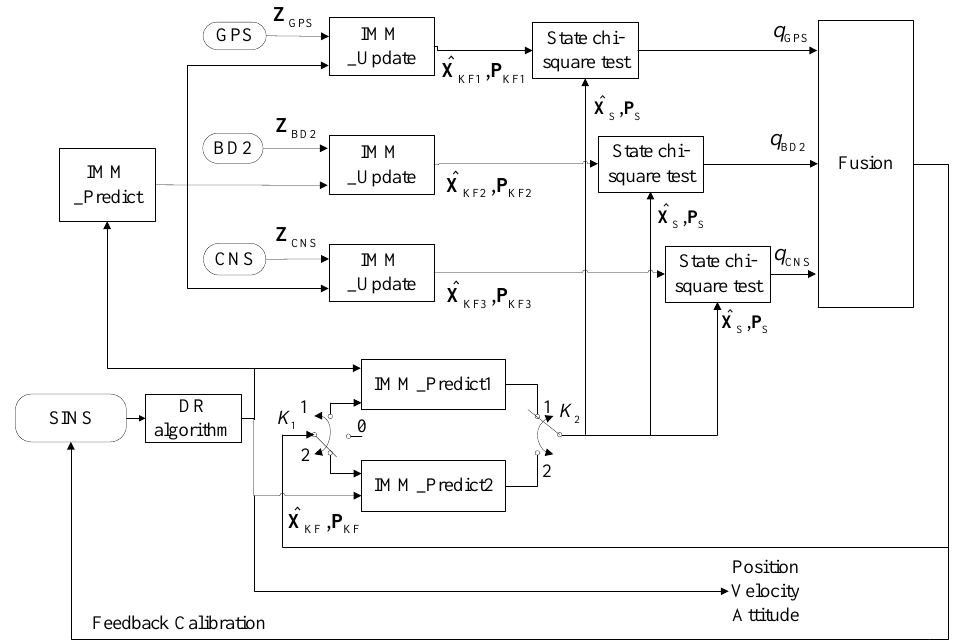
Figure 4. Block diagram of the failure detection